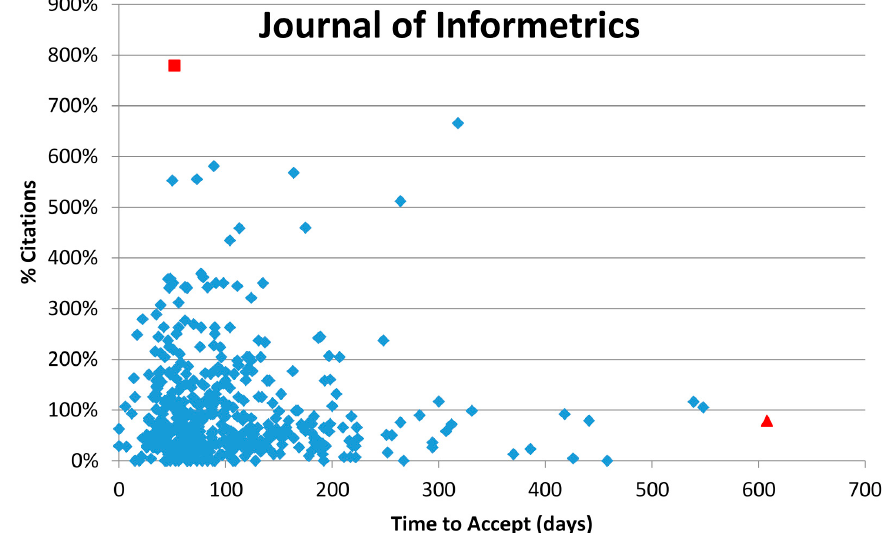
Figure 2. Scatter plot of times to accept versus citations (as percentage ratio of citations to citations per paper in a specific year) of papers from Journal of Informetrics ( n = 471, r = − 0.02). Extreme outliers are marked with red symbols: a rectangle Reference [10] and a triangle Reference [11].